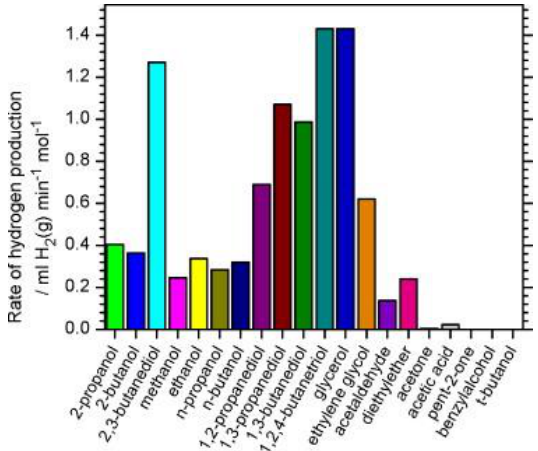
Figure 12. Hydrogen evolution rates under irradiated Pd/TiO 2 catalyst in the presence of different alcohols. Reprinted with permission from [102]. Copyright Elsevier, 2011.